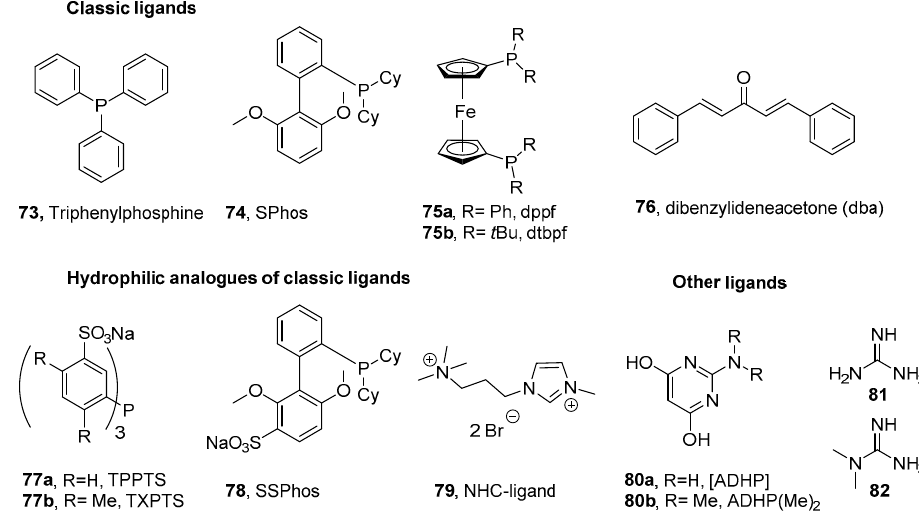
Figure 11. Ligands used Suzuki–Miyaura cross-coupling reactions on peptides. Classical ligands ( 73 – 76 ) that have commonly been used in the early developments on protected peptide substrates.